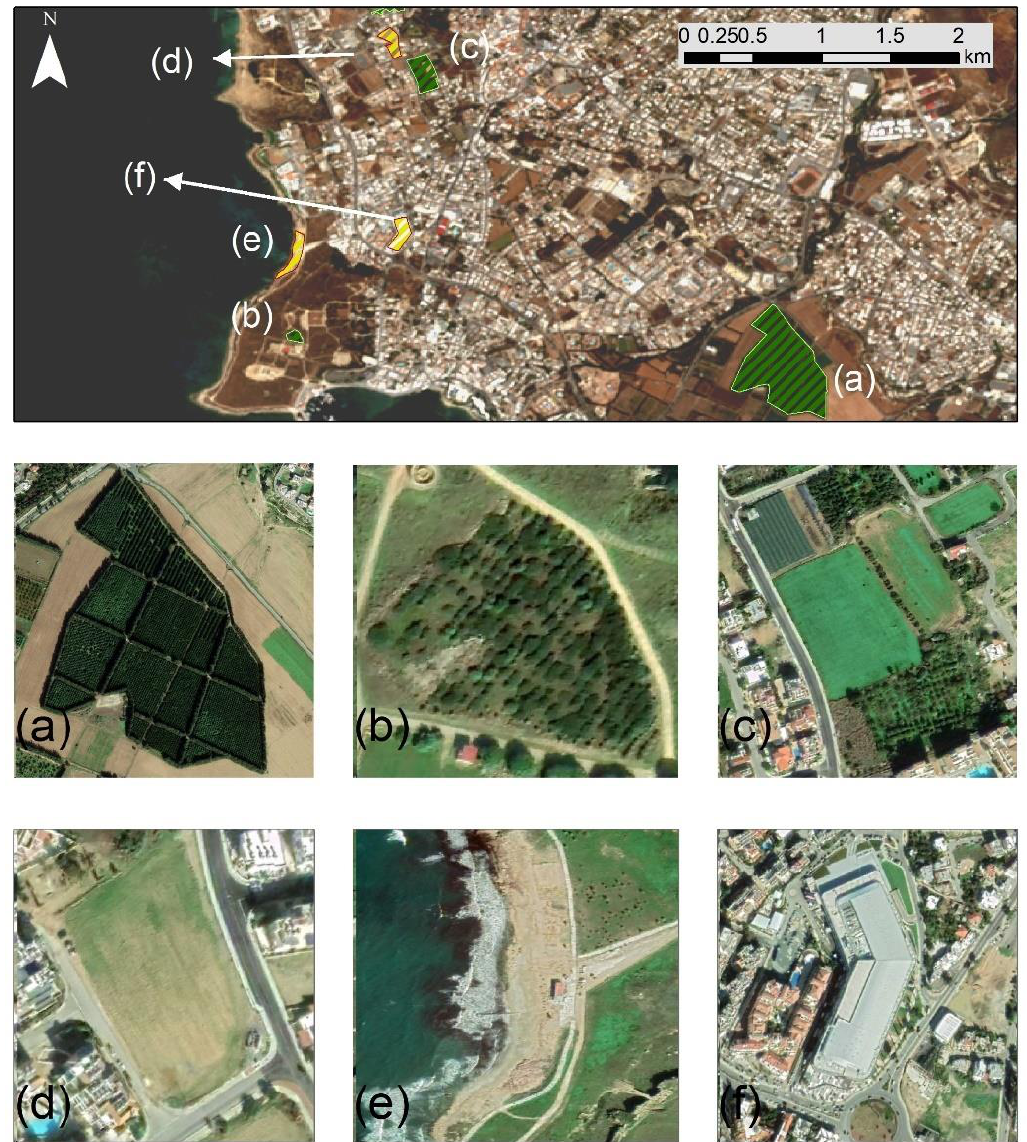
Figure 7. Ground truth data as polygons extracted from the OpenStreetMap service used as “vegetated” and “non-vegetated” areas (top). ( a – c ) shows a high-resolution optical preview of the vegetated areas at Google Earth, while ( d – f ) the non-vegetated areas.